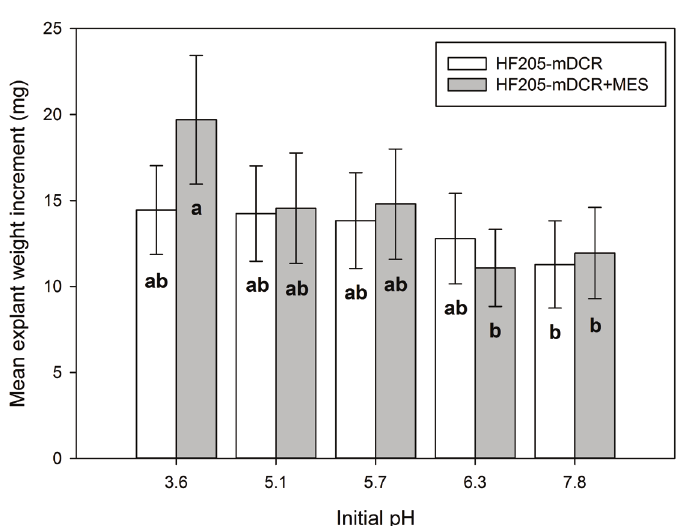
Figure 4. Mean explant weight increment changes (mg) among medium types at each initial pH level from HF205. After surface sterilization and dissection, inner vegetative buds from HF205 were placed on either mDCR or mDCR+MES medium at each initial pH level (3.6, 5.1, 5.7, 6.3, and 7.8) for incubation up to 42 days. These buds were incubated in a growth chamber at 25 ° C with light regime adjusted to 16-hour light followed by 8-hour darkness each day. Bud weight change was recorded using an electronic scale when sample reached each incubation time point. Vertical bars represent mean weight change (mg)±S.E. Means sharing the same letter indicate non-significant difference between means ( P >0.05). Tukey’s (HSD) multiple comparison was